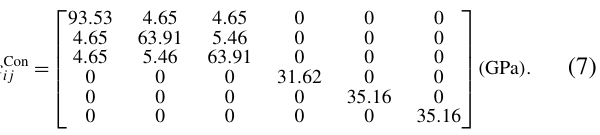
Table 1. Material properties of the numerical model. Material